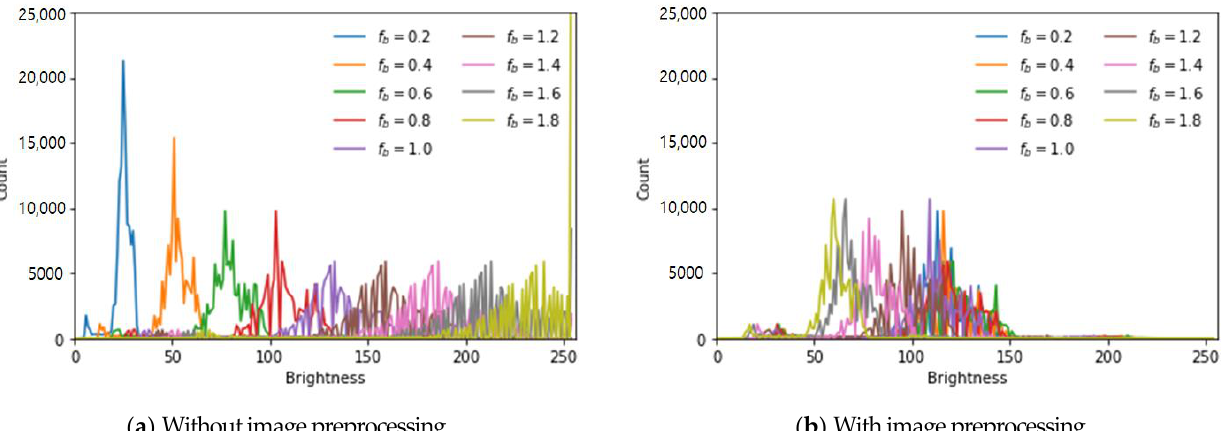
Figure 11. Histogram of the brightness with and without image preprocessing.